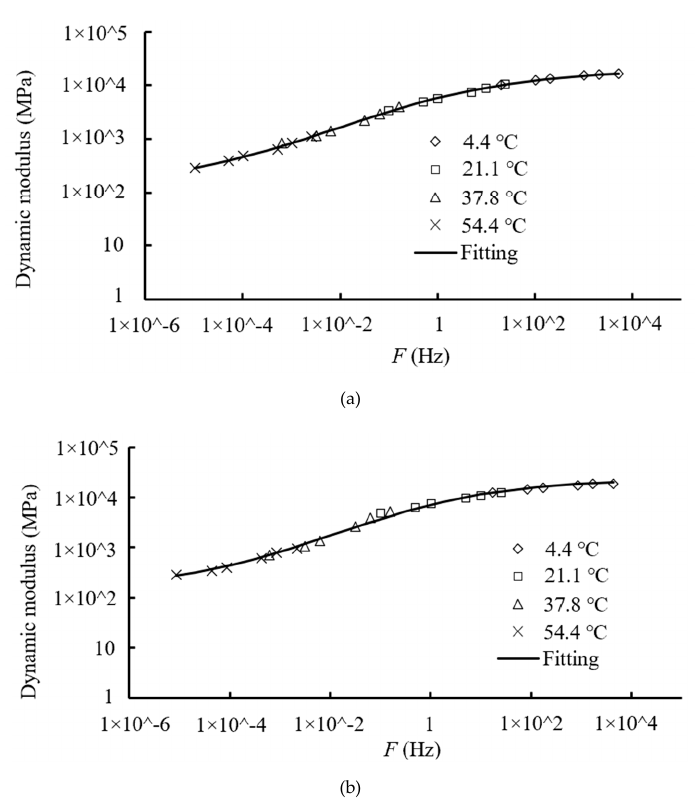
Figure 11. Dynamic modulus master curve: ( a ) BAM, ( b ) HAM.